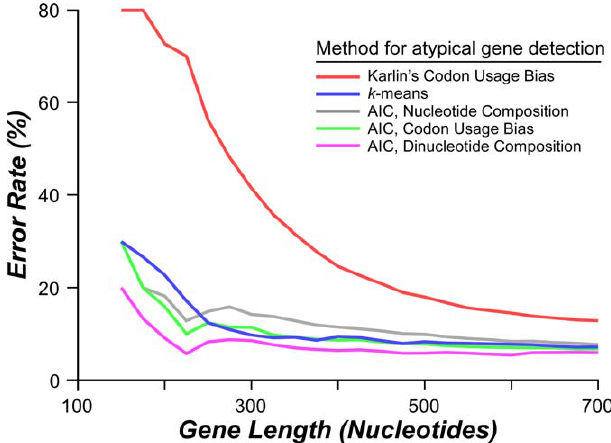
Figure 6. Performance of Parametric Methods in Classifying Short Genes The error rate in proper classification of genes as native or foreign as a function of gene length was assessed for genes within chimeric, artificial genomes. DOI: